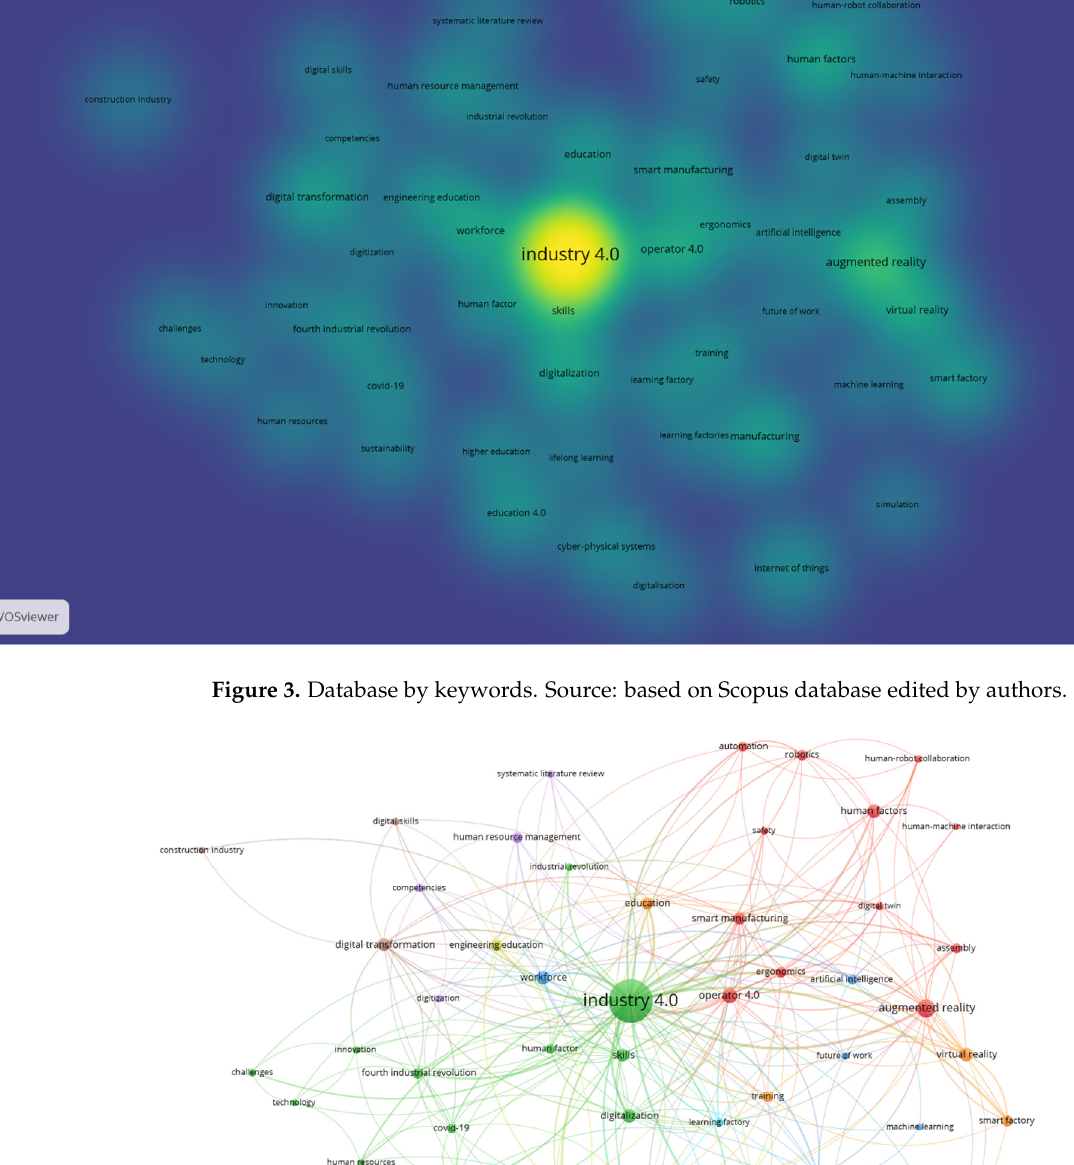
Figure 2. The most connected countries of the database by citations. Source: based on Scopus data- base edited by authors.